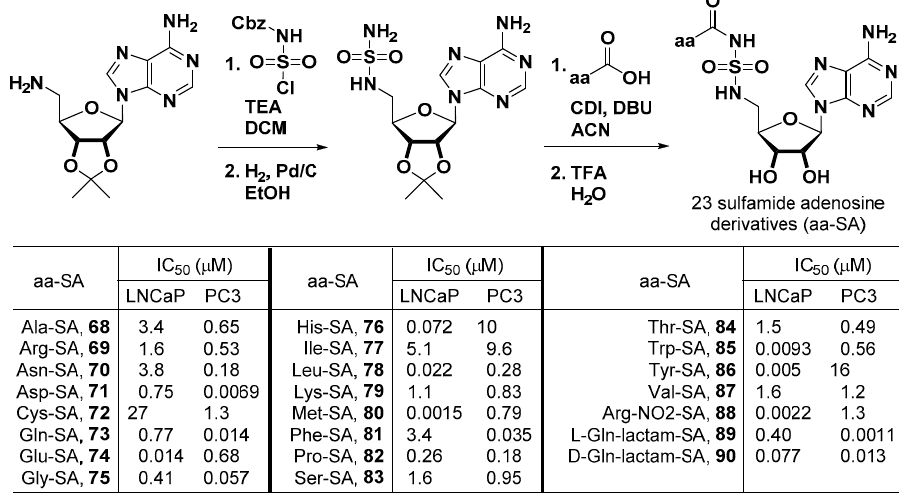
Figure 20. Synthetic scheme of sulfamide adenosine derivatives (aa-SAs) and their biological activities against prostate cancer cell lines.